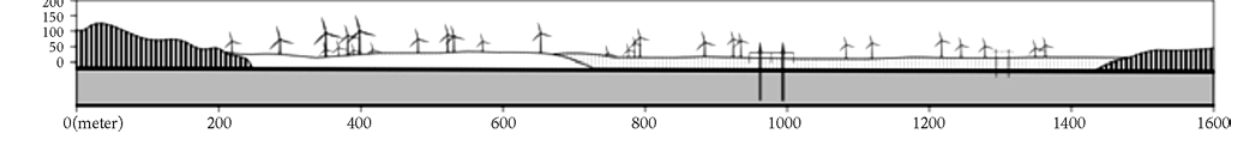
Fig. 3. Visibility of wind turbines from observation place No. 8